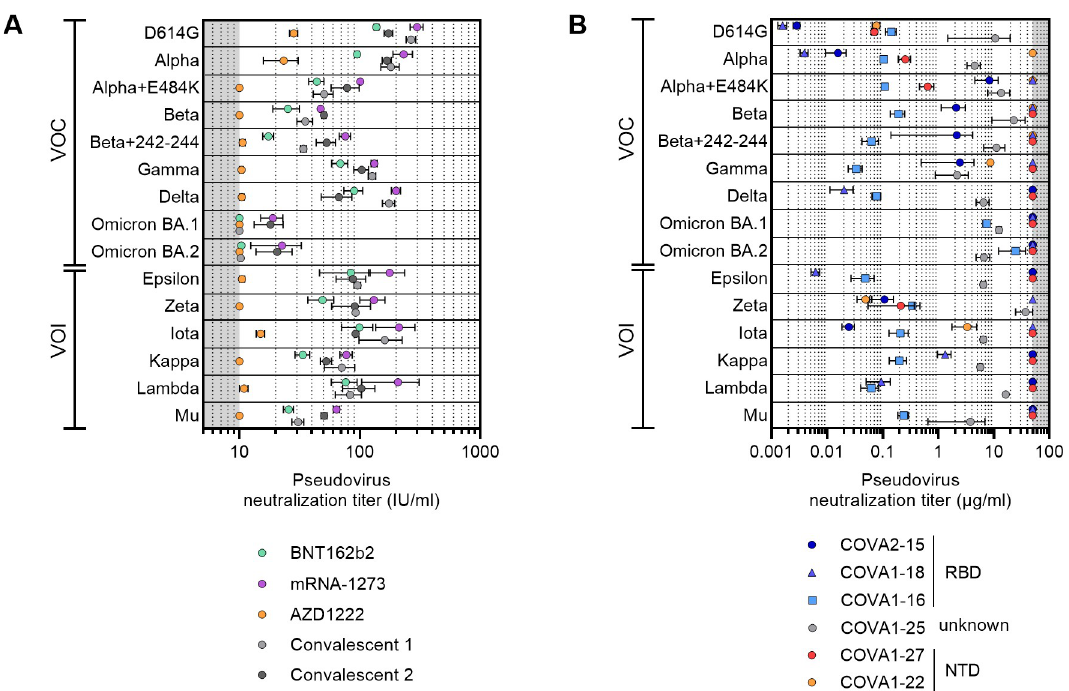
Fig 3. Neutralization titers of pooled sera and monoclonal antibodies against VOCs and VOIs. ( A) Neutralization half-maximal inhibitory concentration (IC 50 ) titers (IU/ml) of SARS-CoV-2 variant pseudoviruses for pooled sera for the vaccination groups (excluding the Ad26.COV2.S group) after completing initial vaccination series. The lower cutoff for neutralization was set at an IC 50 of 10 IU/ml (grey shading). Convalescent group 1 (light gray) consists of pooled COSCA sera representing COVID-19 patients between 4–6 weeks post symptom onset and convalescent group 2 (dark gray) consists of pooled RECoVERED sera representing COVID-19 patients up to seven months post symptom onset (median three months), who experienced mild to severe COVID-19. Vaccine groups are indicated by colors with BNT162b2 in green, mRNA-1273 in purple and AZD1222 in orange. VOCs, variants of concern; VOIs, variants of interest. All data points shown here represent mean and standard deviation of at least three replications. (B) Half-maximal inhibitory concentrations (IC 50 ) of SARS-CoV-2 variant pseudoviruses neutralization for monoclonal antibodies isolated from COSCA participants [59]. The cutoff for neutralization was set at an IC 50 of 50 μ g/ml (grey shading). All data points shown here represent mean and standard deviation of at least three